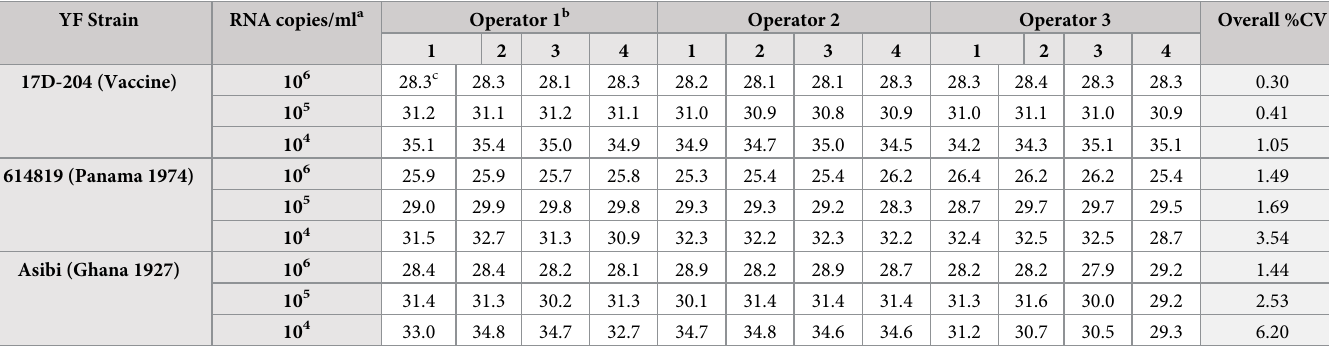
YF, yellow fever; RNA, ribonucleic acid; %CV, coefficient of variation. a Approximate RNA copies/ml b Three operators tested RNA extract in quadruplicate on 3 separate